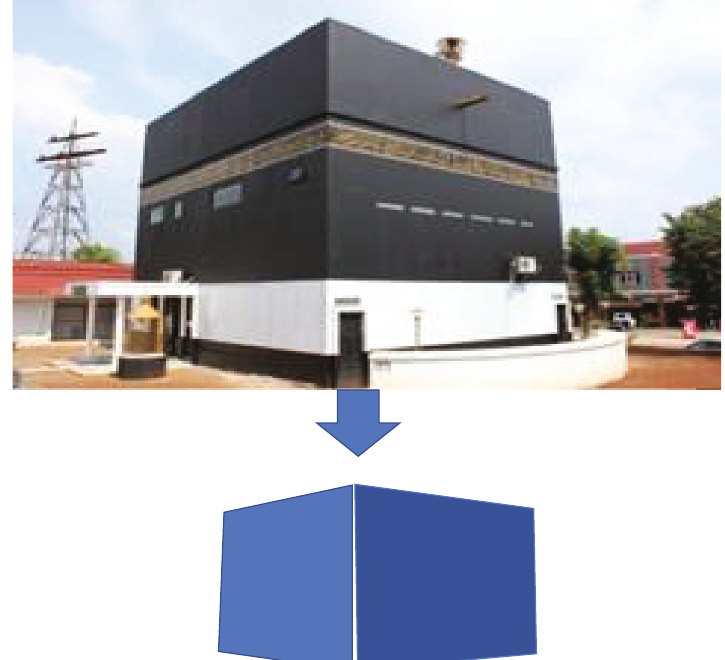
Figure 40: Construction building number ̂ 1